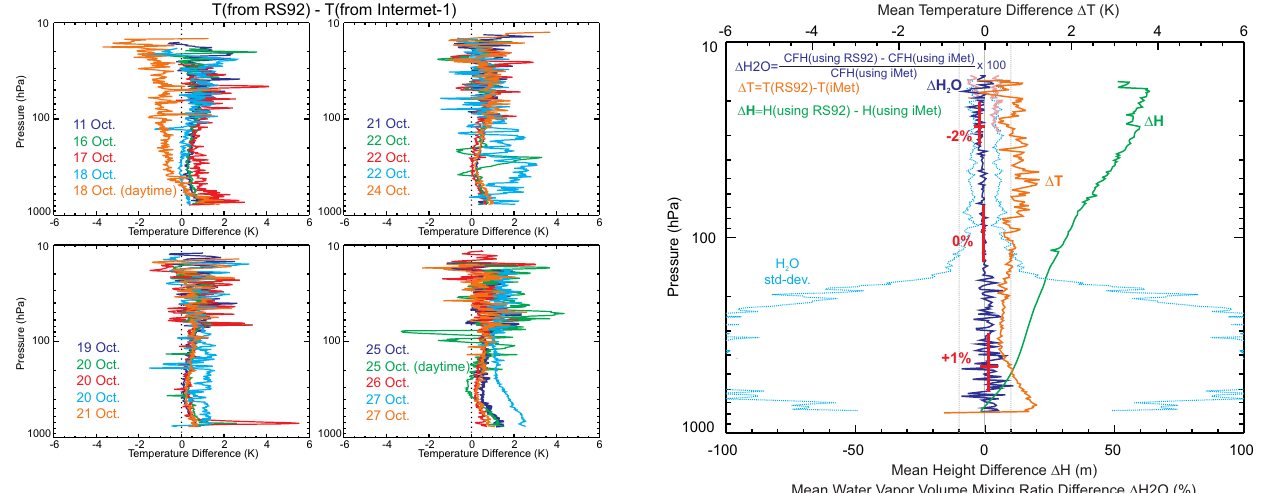
Fig. 3. Measured temperature difference between the Vaisala RS92 and the InterMet iMet-1 radiosondes when both radiosonde types were mounted on the same payload (20 balloon flights). All flights at nighttime unless otherwise specified.